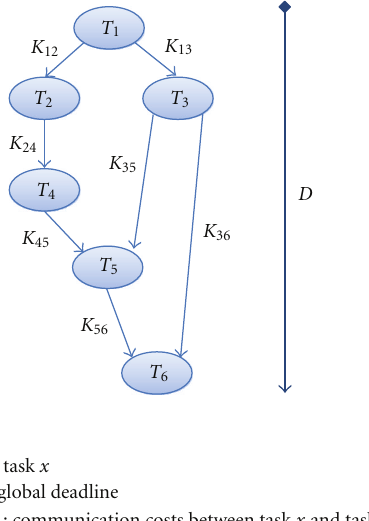
Figure 4: Example task graph with global deadline, interrelation, and communication